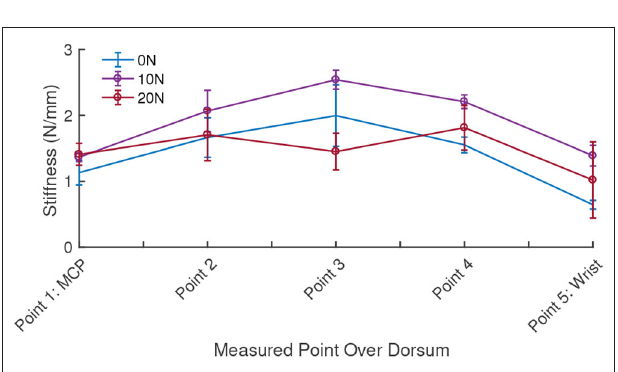
FIGURE 13 | Measured stiffness of the hand dorsum for five equally spaced points along the second metacarpal at three levels of grasp force applied by the